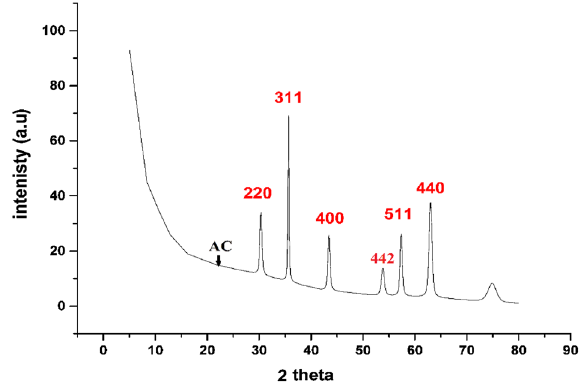
Figure 2. XRD pattern of the prepared MG-OPAC.